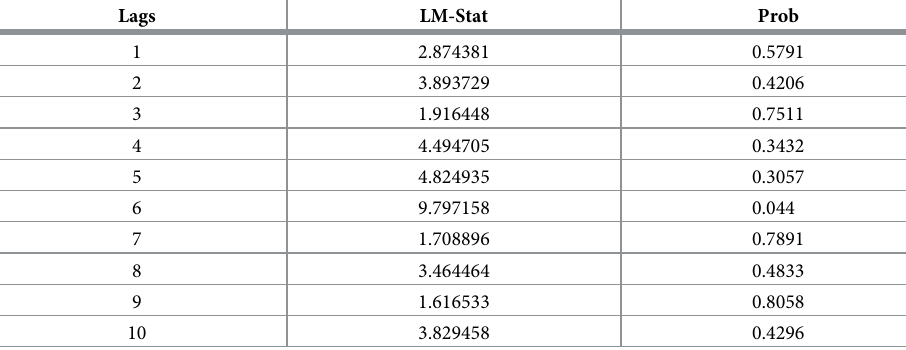
Table 17. Serial correlation LM test for British data when P = 1 (Fisherian model).